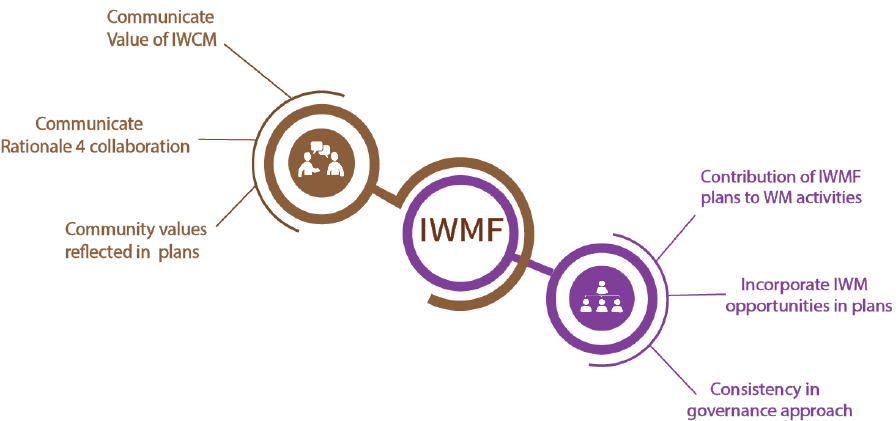
Figure 12. IWMF in Victoria,